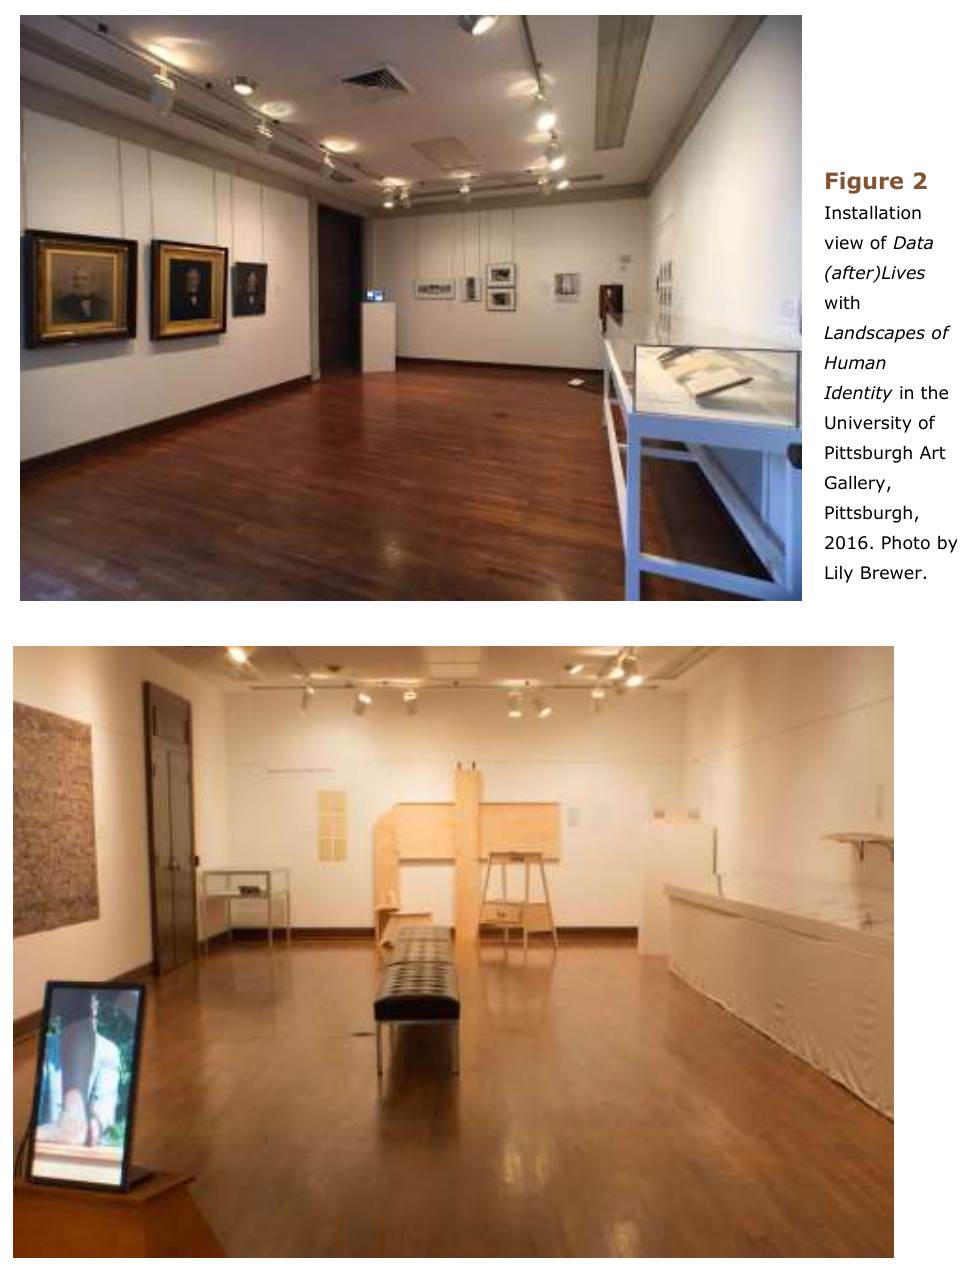
Installation view of Data (after)Lives with reconstruction of the Bertillon machine, Bertillon cards,